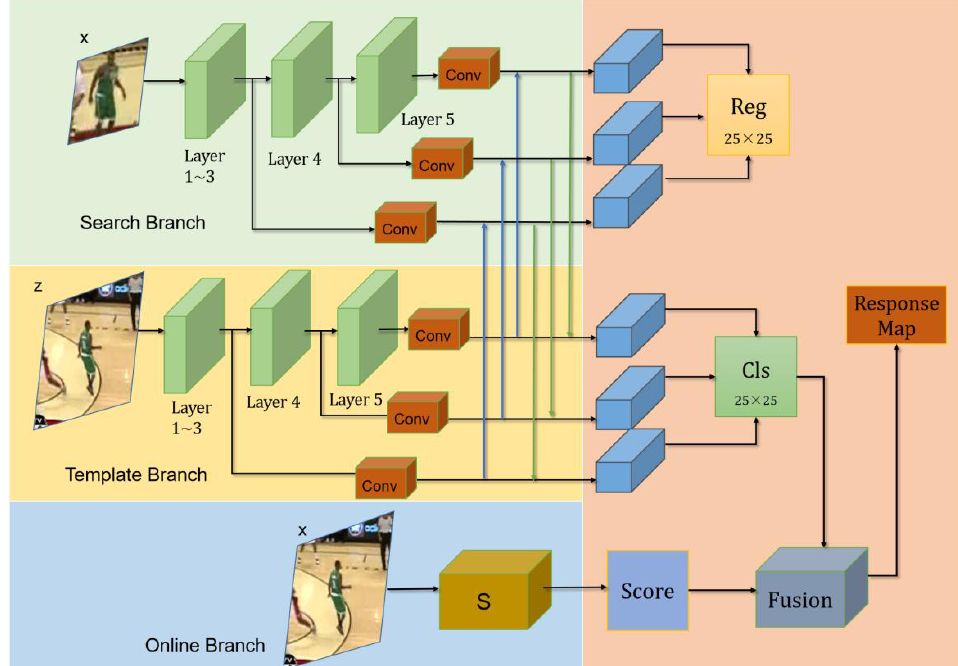
Figure 2. The overall structure of SiamOT.